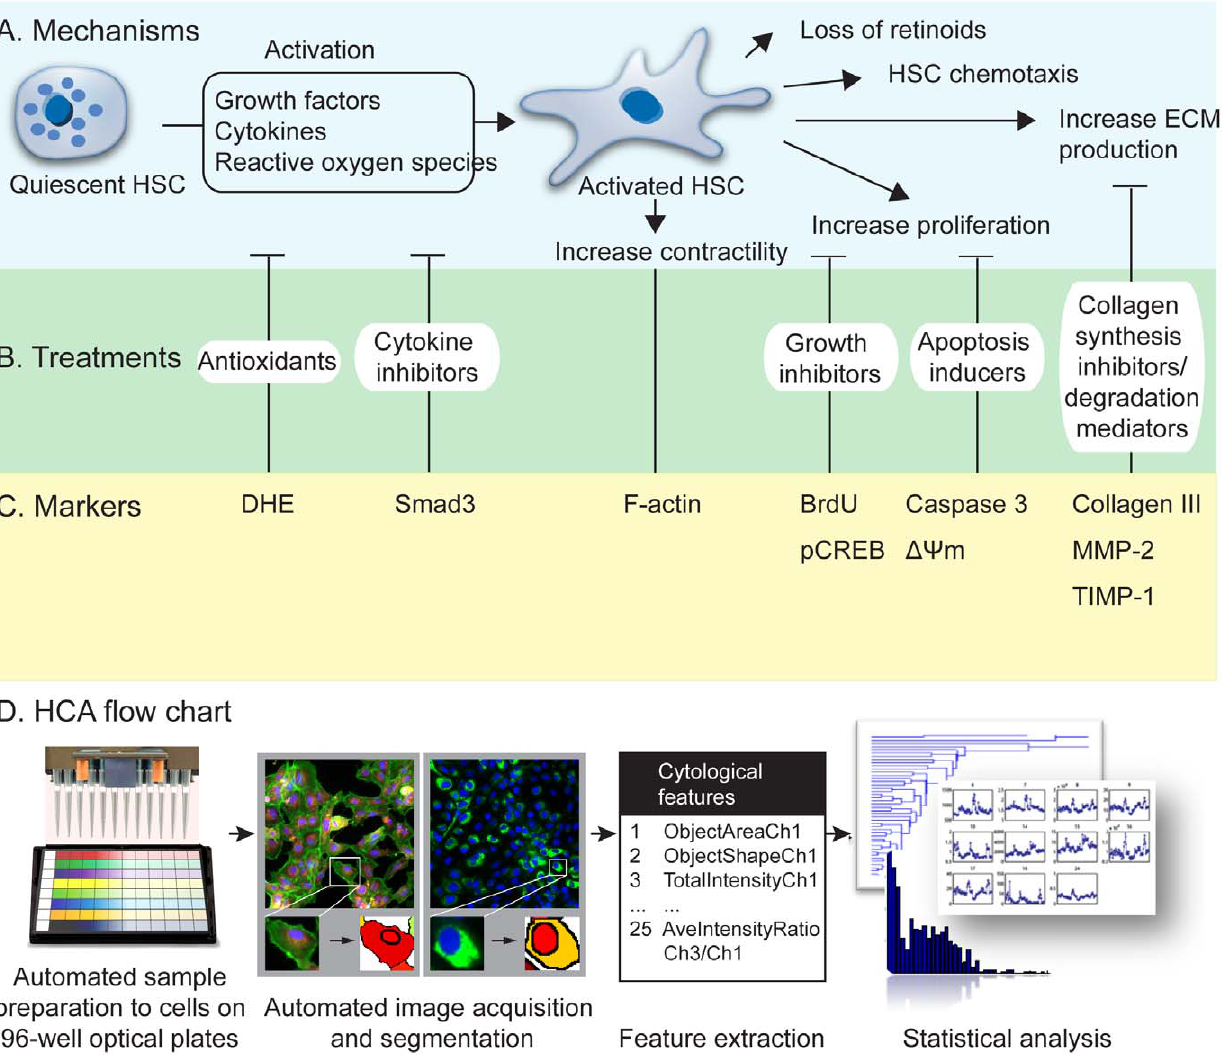
Figure 1. Principle for evaluation of anti-fibrotic drug efficacy. (A) Phenotypic changes of hepatic stellate cells during activation. (B) Potential sites for therapeutic interventions and (C) markers that track the effects of the interventions. (D) The high-content analysis system with 4 core components (sample preparation, automated image acquisition, image processing and statistical analysis).